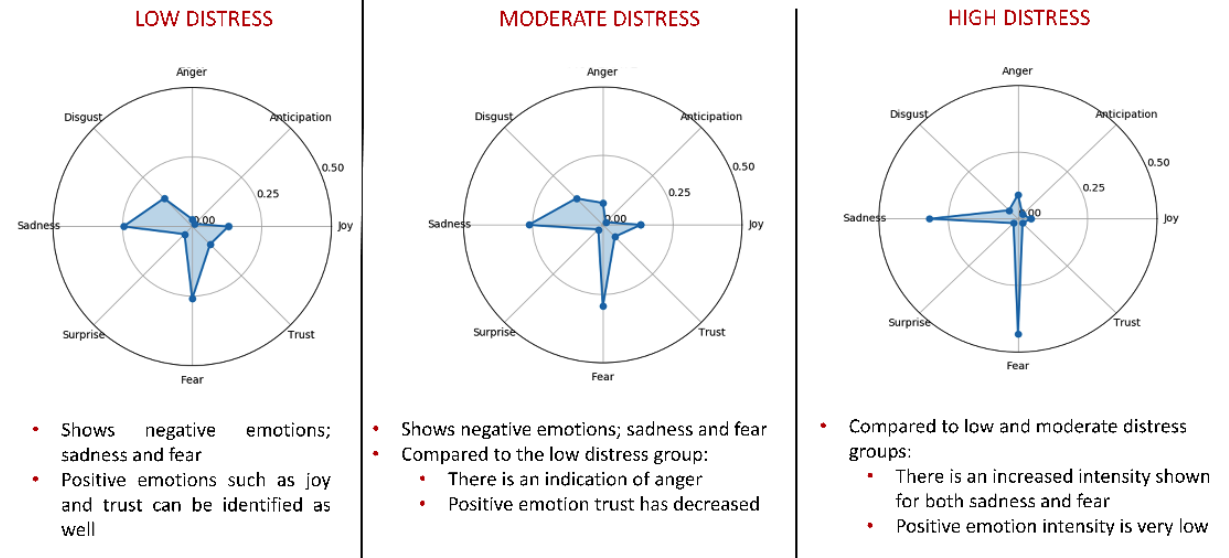
Figure 4. AICF classifications of emotions across levels of participant distress. Note: Given the small sample of data available, the emotion intensity scale was adjusted to